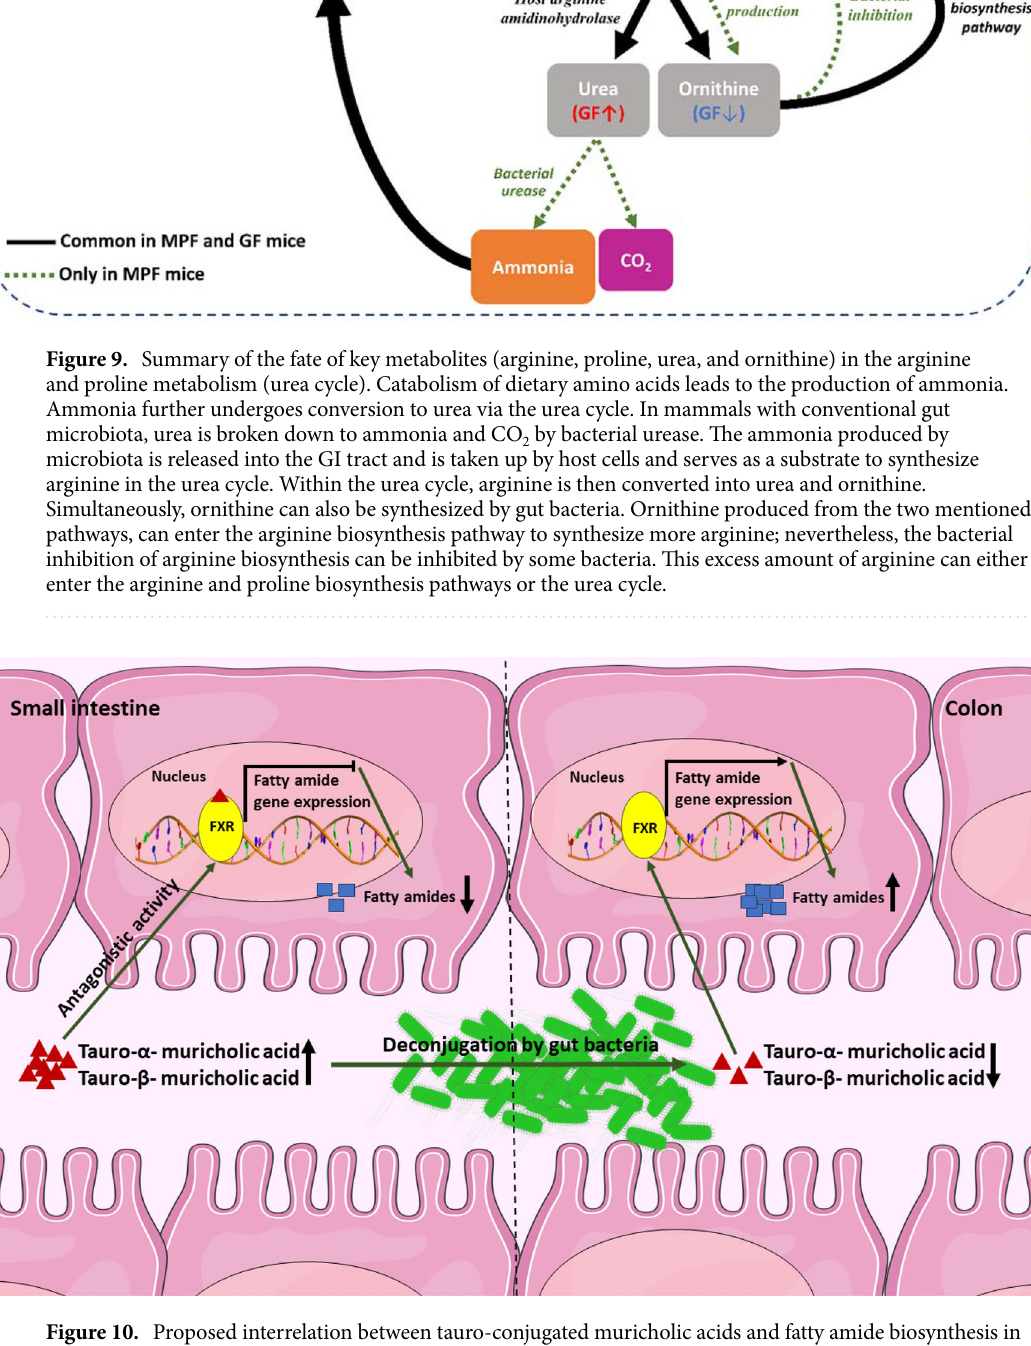
Figure 10. Proposed interrelation between tauro-conjugated muricholic acids and fatty amide biosynthesis in proximal and distal GI tract. When the FXR is bound to tauro-α- and β-muricholic acids in the upper section of the GI tract, the fatty amides biosynthesis is downregulated. As tauro-α- and -β-muricholic acids pass through the GI tract, they get deconjugated by gut microbiota. Therefore, there are fewer tauro-α- and β-muricholic acids are available to bind to FXR in the lower section of the GI tract. Thus, the FXR expression is upregulated in this area, and that may explain the higher abundances of fatty amides in the lower part of the GI